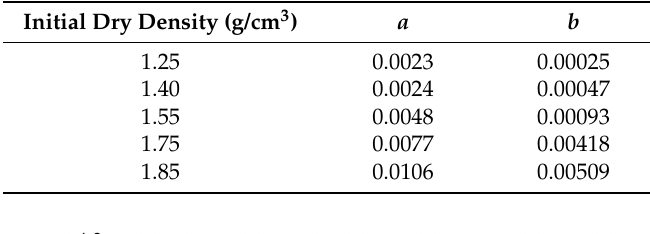
Figure 13. Relationship between swelling pressure and swelling time for MB specimens with the same water content and different initial dry densities under saline water conditions. Table 6. Relationship between the initial dry density and time/swelling pressure.